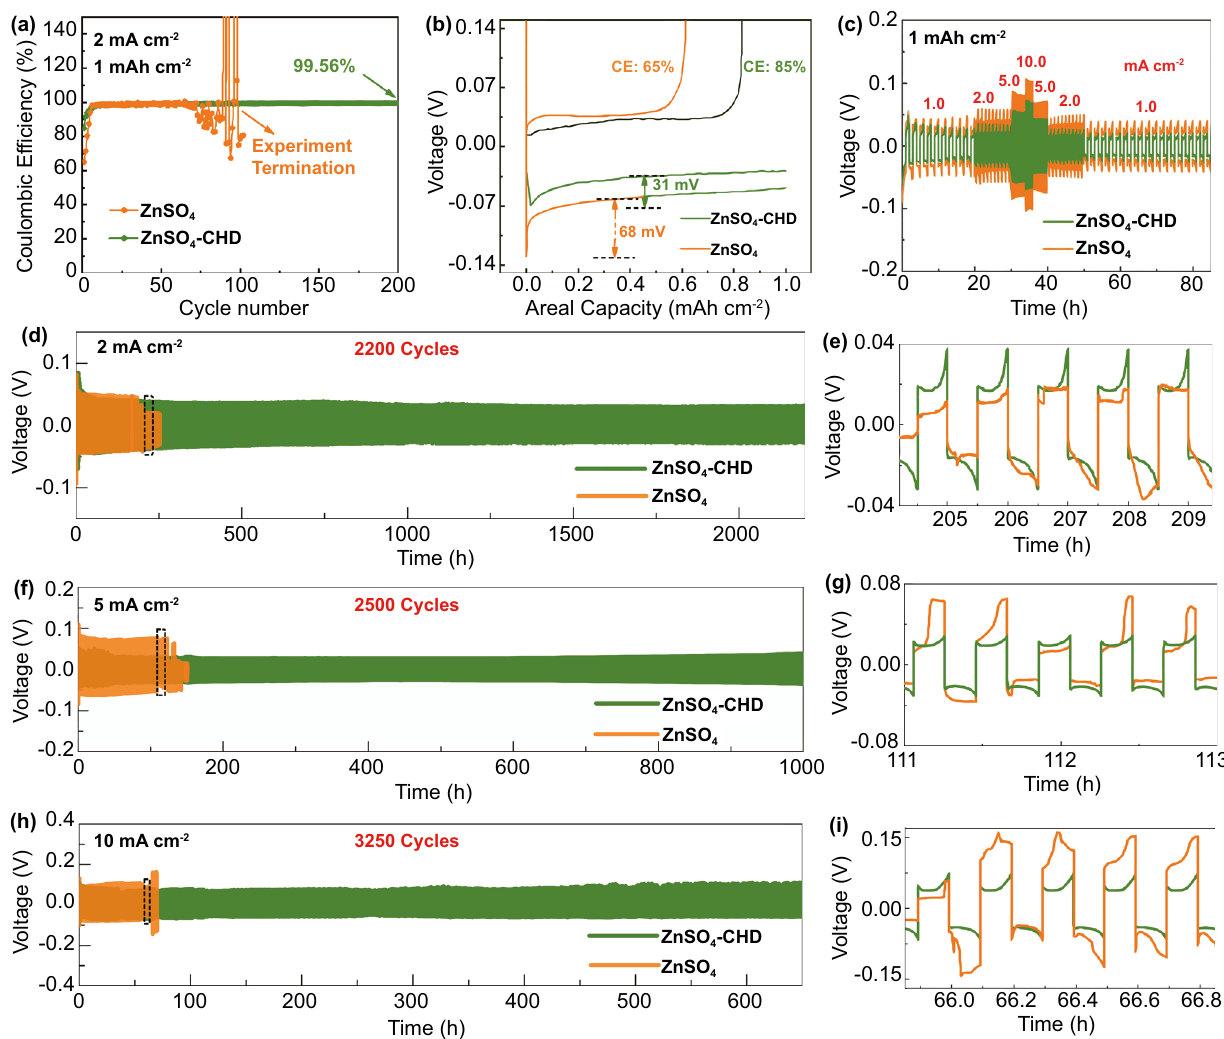
Fig. 5 a The coulombic efficiency of the Zn plating/stripping at 1 mA cm −2 with the fixed capacity of 1 mAh cm −2 in Zn|Cu cells; b voltage profiles of Zn plating/stripping process on the copper mesh; c Rate galvanostatic cycling of Zn|Zn symmetrical cell at 1, 2, 5, and 10 mA cm −2 with the capacity of 1 mAh cm −2 ; d–i long‑term galvanostatic cycling of Zn|Zn symmetrical cell at 2 mA cm −2 ( d–e ), 5 mA cm −2 ( f–g ) and 10 mA cm −2 ( h–i ) with the fixed capacity of 1 mAh cm −2 . e , g , i are the magnified curves of the selected time (i.e., the dotted rectangles) in ( d , f , h ),